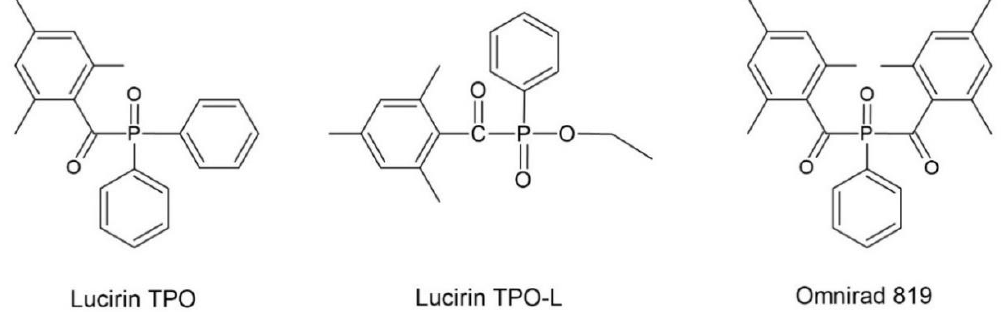
Figure 4. Structure of the free-radical photoinitiators–acylphosphine oxides.